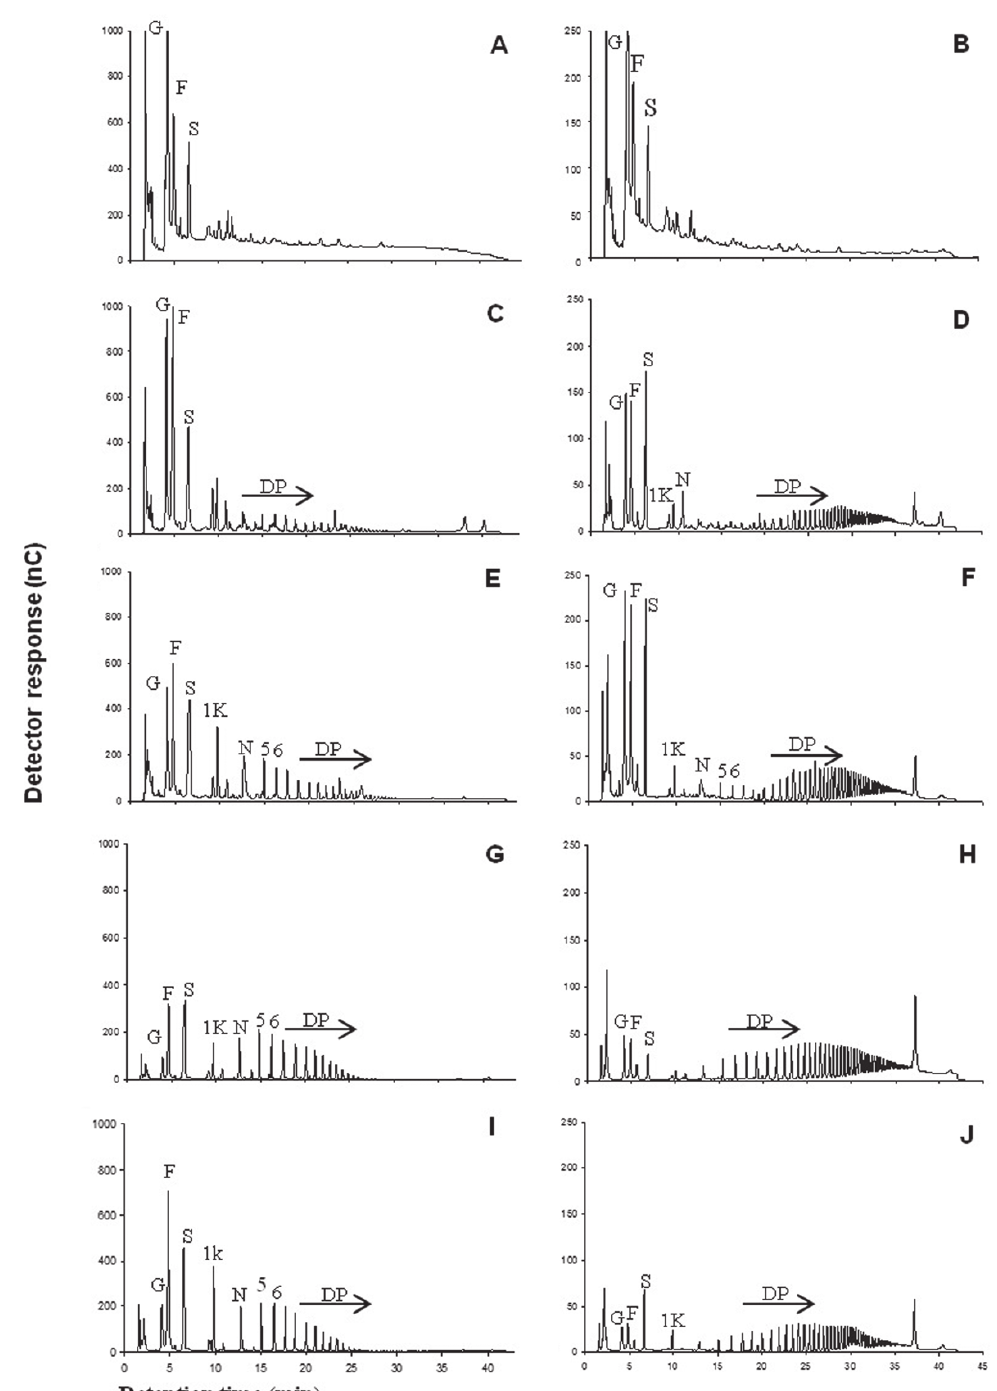
Fig. 5 - HPAEC/PAD profiles of soluble neutral carbohydrates of vegetative aerial and underground organs of Dimerostemma vestitum . Oligosaccharide (A, C, E, G, I) and polysaccharide (B, D, F, H, J) fractions of leaves (A, B); Stem (C, D); Lateral roots (E, F); Xylopodium: Peripheral (G, H) and central (I, J) regions.Fructose (F);Glucose (G);Sucrose (S); 1-Kestose (1K); Nystose (N); Arrows indicate the increase in degree of polimerization